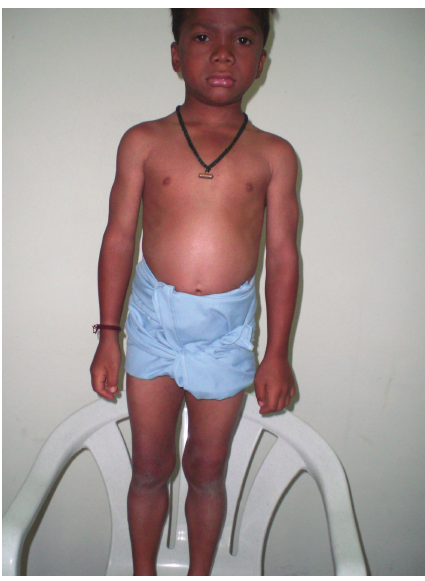
Figure 3: A ten-year-old boy with pseudomuscular hypertrophy in Kocher-Debre-Semelaigne syndrome.